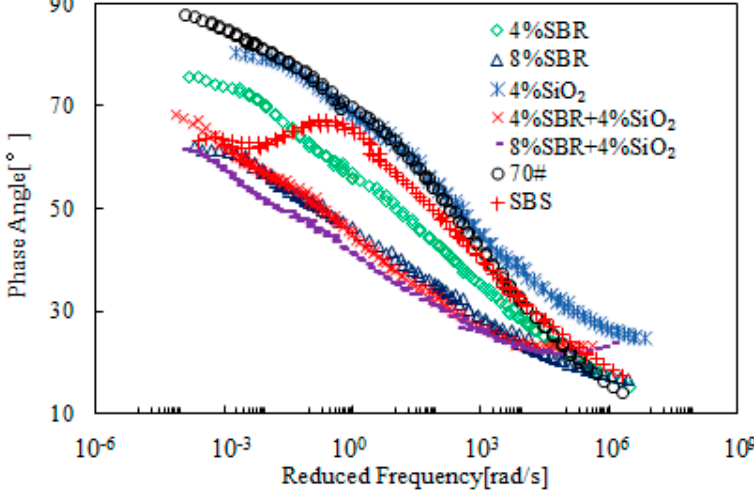
Figure 16. Master curves of phase angle of SBR + SiO 2 -modified emulsified asphalt.